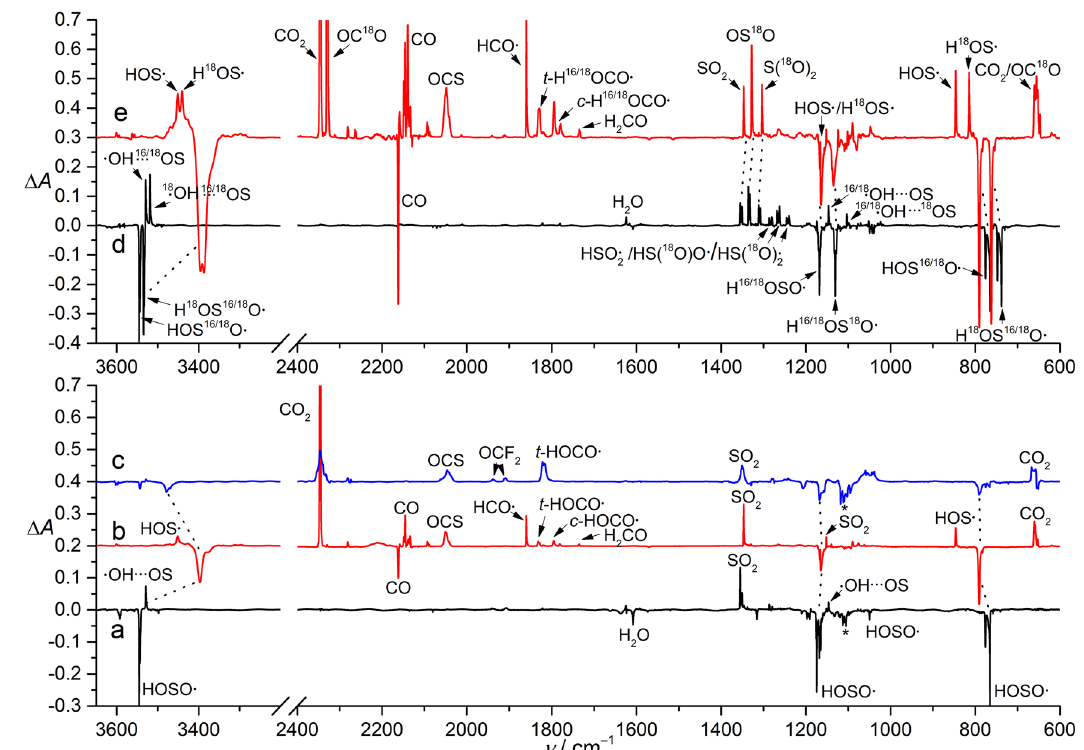
Fig. 4 | Reactions of HOSO • in matrixes upon irradiation. a Infrared (IR) differ- ence spectrum re fl ecting the change of the Ar ‑ matrix isolated high ‑ vacuum fl ash pyrolysis (HVFP) products of CHF 2 S(O)OH upon irradiation at 266nm (80min, 10K). b IR difference spectrum re fl ecting the change of the CO ‑ matrix isolated HVFP products of CHF 2 S(O)OH upon irradiation at 266nm (7min, 16K). c IR dif- ference spectrum re fl ecting the change of the CO 2 ‑ doped Ar-matrix (50: 1000)